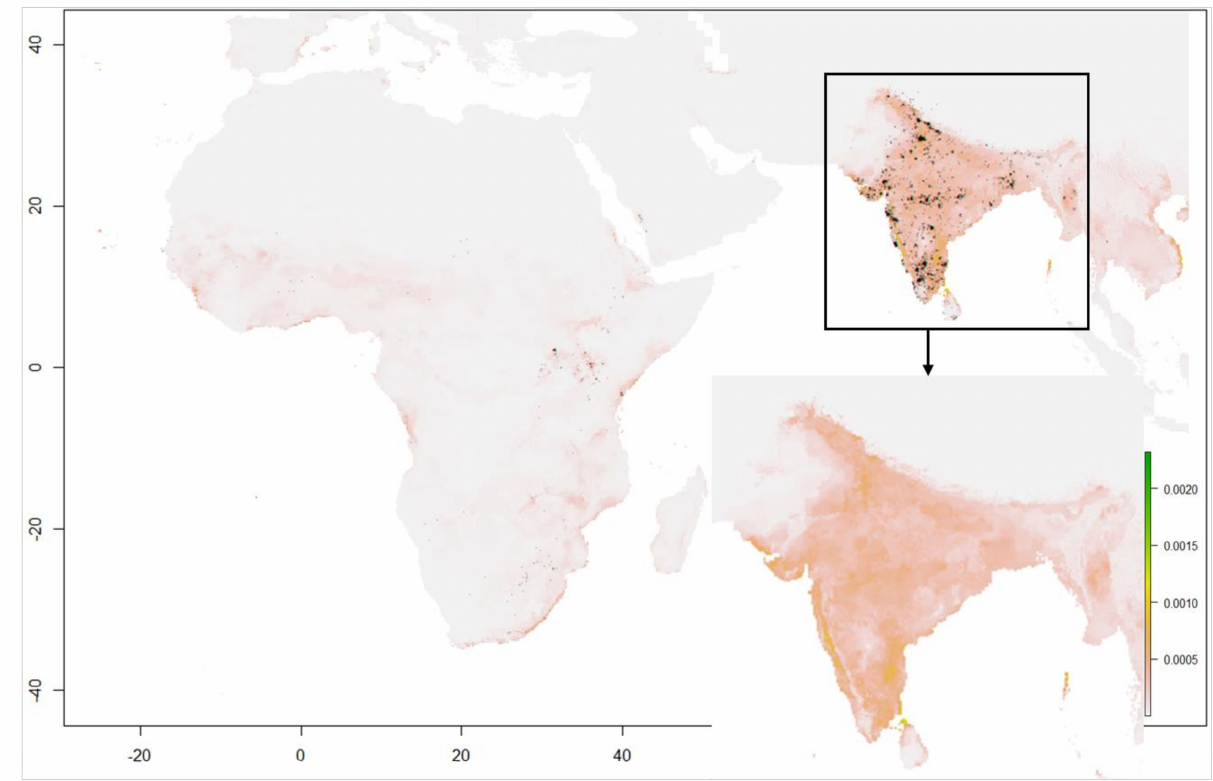
Figure 5. Habitat suitability modelling in 2006–2020 for the June-September